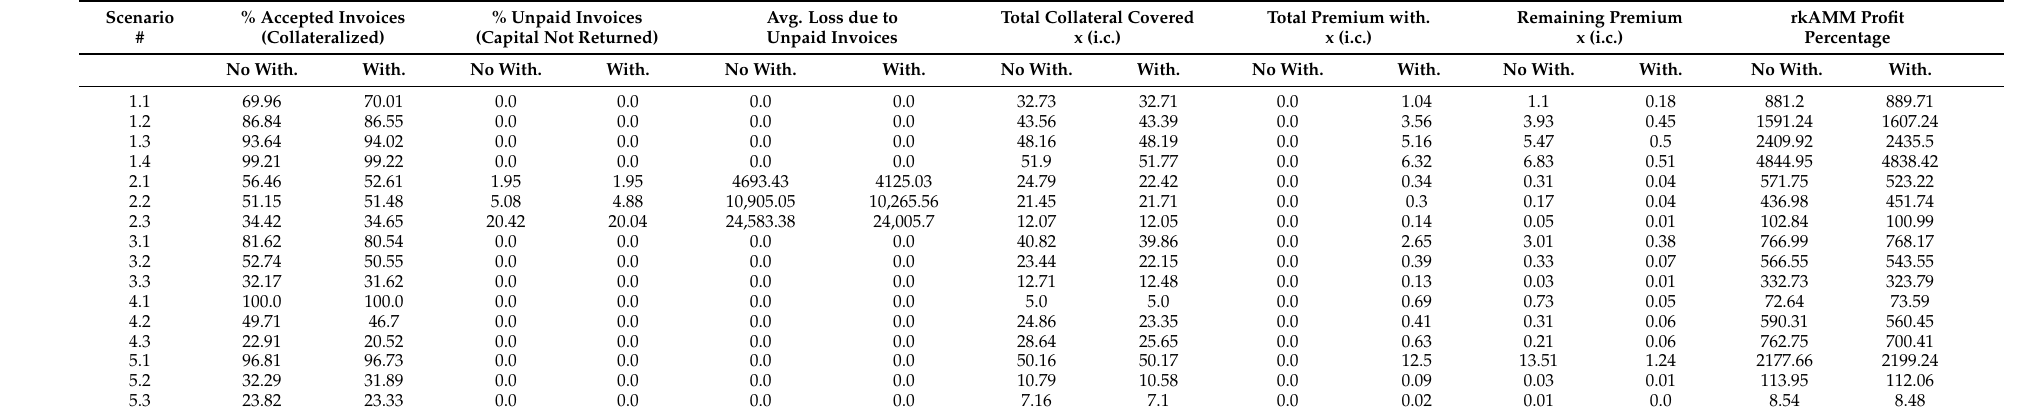
Table 13. rkAMM results. Every 90 days, 50% of the premium obtained is withdrawn.